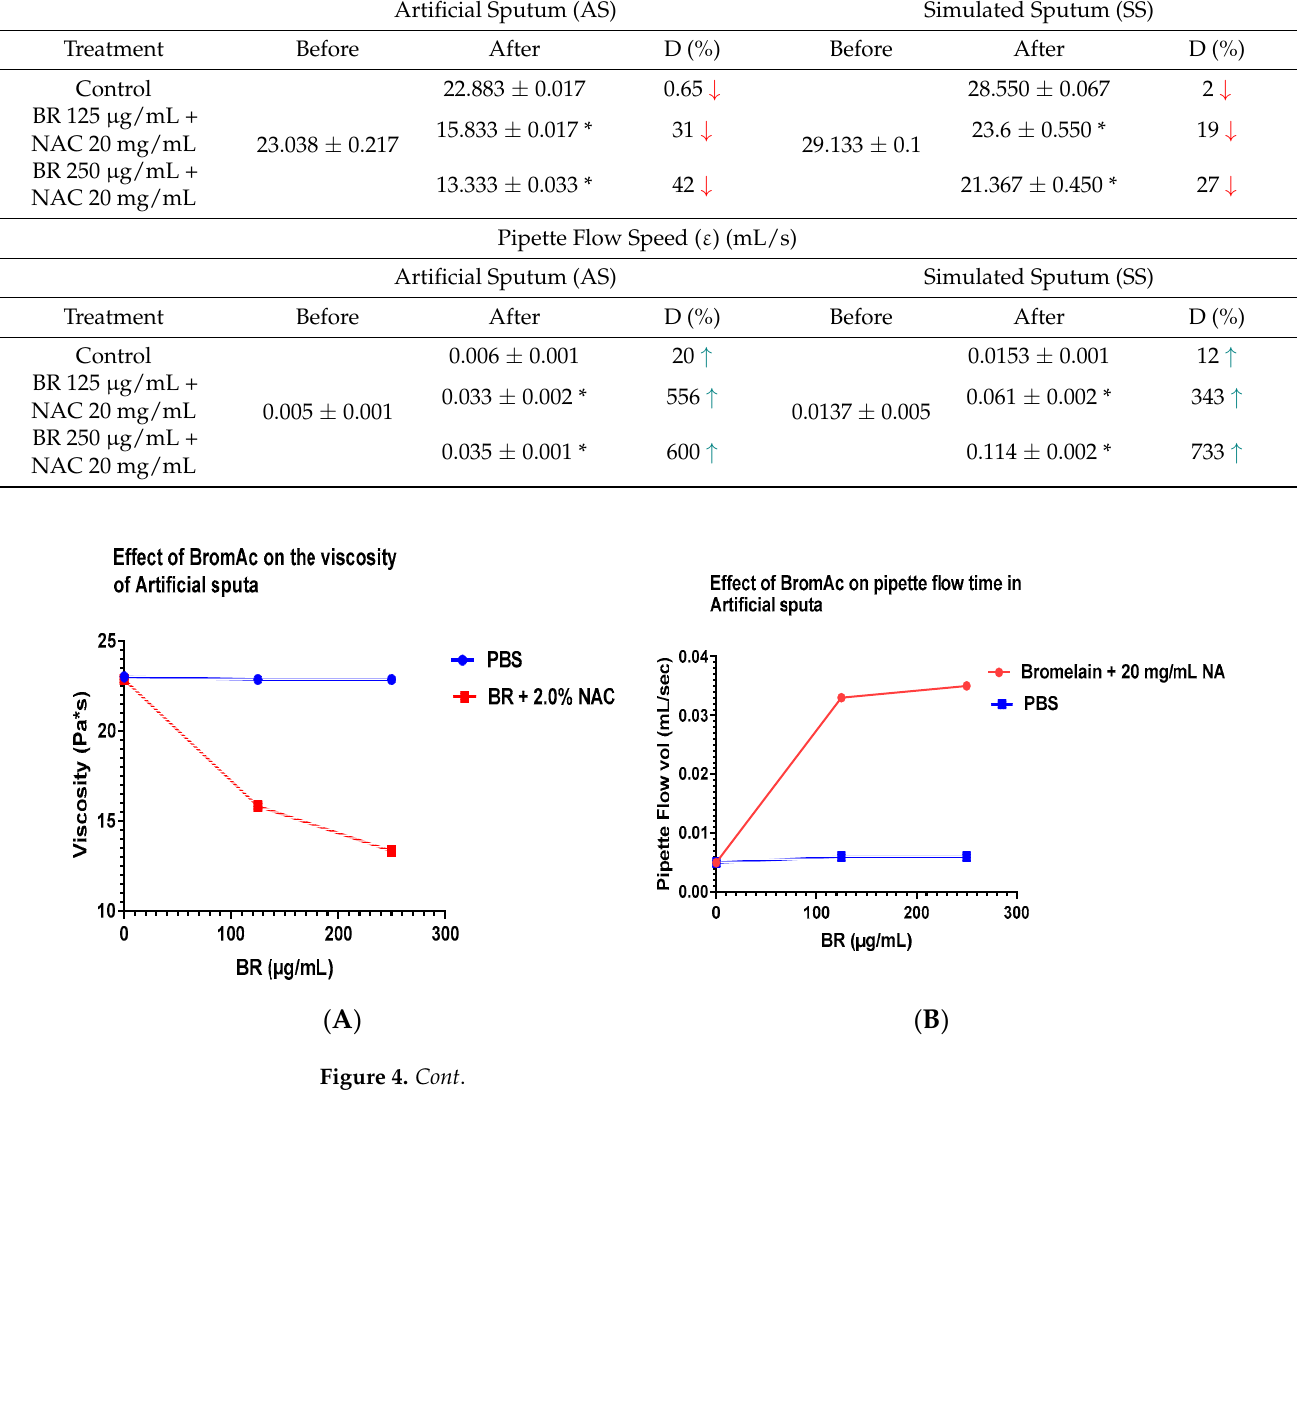
Figure 4. ( A ) In artificial sputa (AS), there was a noticeable drop in viscosity after treatment with BromAc (bromelain 125 and 250 µg/mL + NAC 20 mg/mL). ( B ) In AS, the flow rate increased with the addition of BromAc. ( C ) In simulated sputa (SS,) there was a considerable drop in viscosity with the addition of 125 or 250 µg/mL bromelain + NAC 20 mg/mL. ( D ) In SS, there was almost a linear increase in flow rate (pipette emptying time) with the addition of increasing amounts of bromelain and 20 mg/mL NAC. Table 4. The effect of aerosolized BromAc (bromelain (BR) 125 or 250 µg/mL + NAC 20 mg/mL) on both artificial (AS) and simulated sputa (SS) using two parametric measurements such as viscosity ( γ ) and pipette flow time ( ε ). Data presented as mean ± SD. Test samples were compared with con- trol after treatment for significance testing; * = p < 0.05; ↓ = decrease; ↑ = increase. Viscosity( γ ) Measurements (Pa*s) Artificial Sputum (AS)